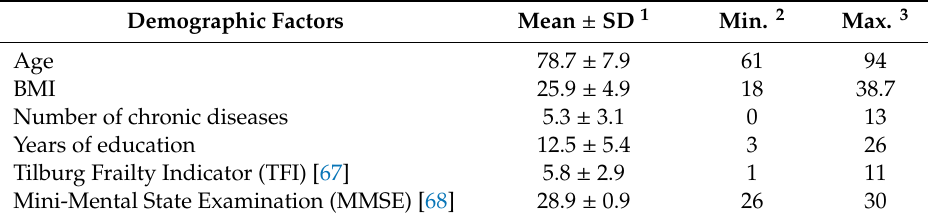
Table 2. Descriptive statistics of the demographic